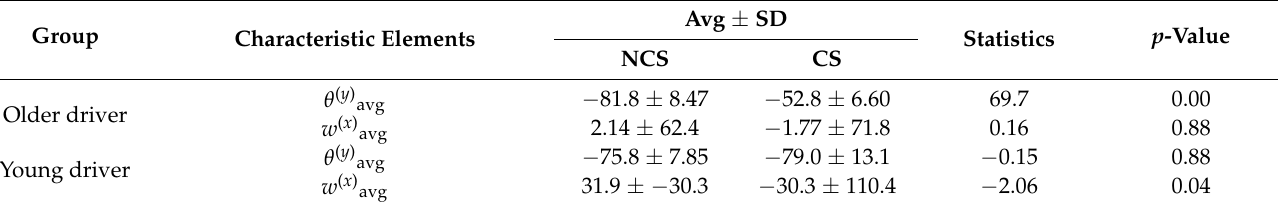
Table 11. Behavioral characteristics of NCS and CS groups in Experiment III.